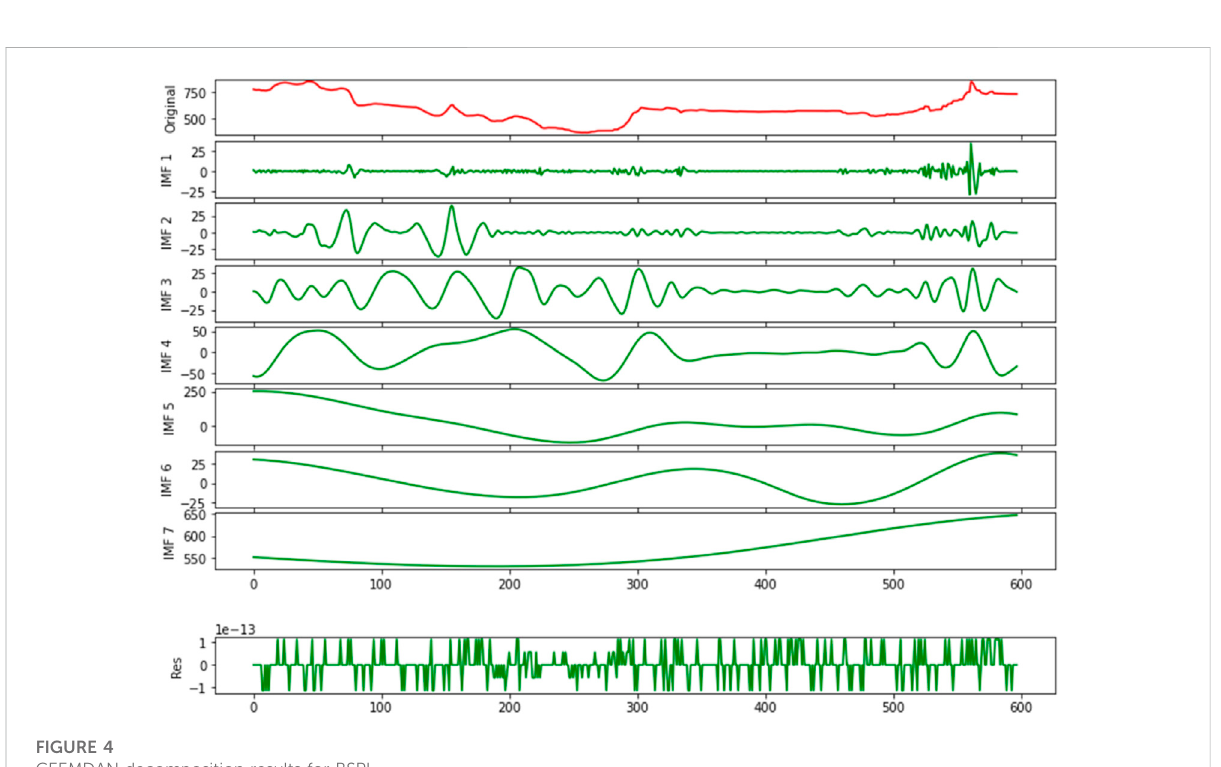
FIGURE 4 CEEMDAN decomposition results for